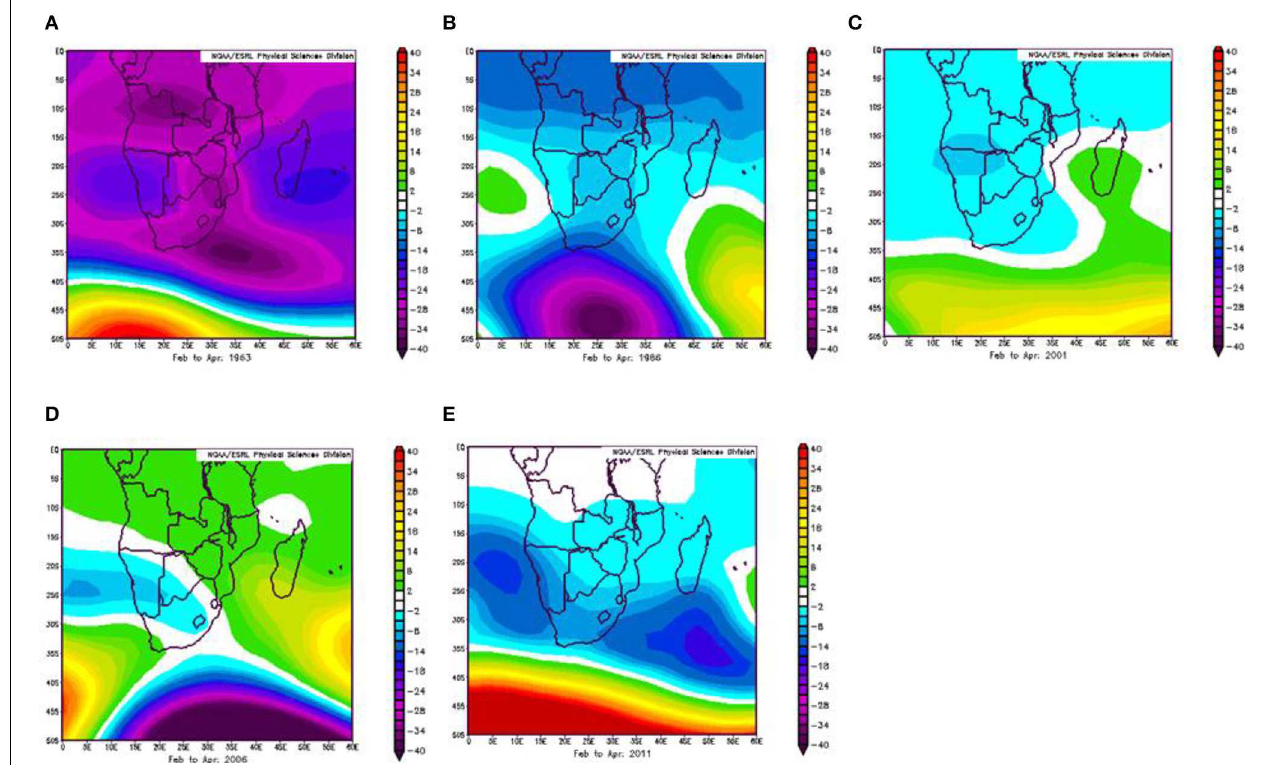
FIGURE 7 | FMA geopotential height anomalies at the 500 hPa level for (A) 1963, (B) 1986, (C) 2001, (D) 2006, and (E) 2011. Contour interval is 2m.